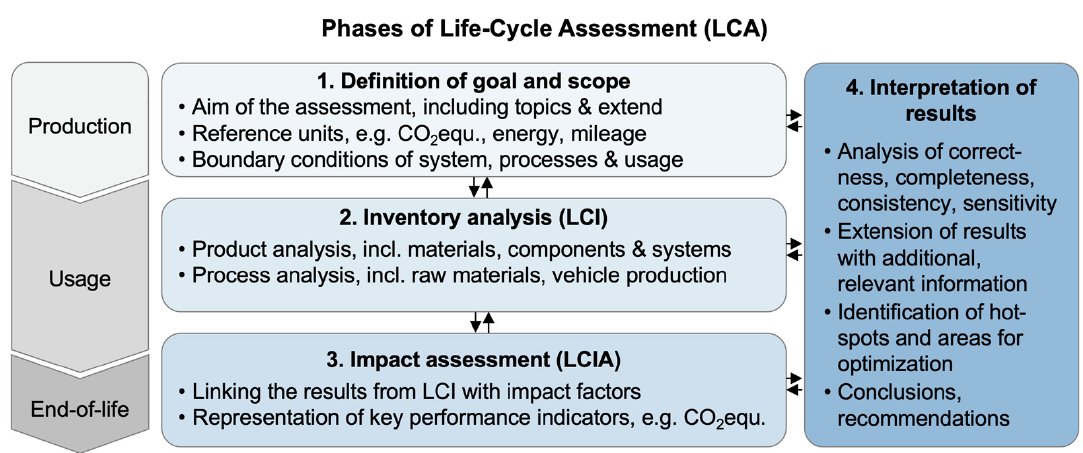
Figure 1. General procedure of an automotive LCA.